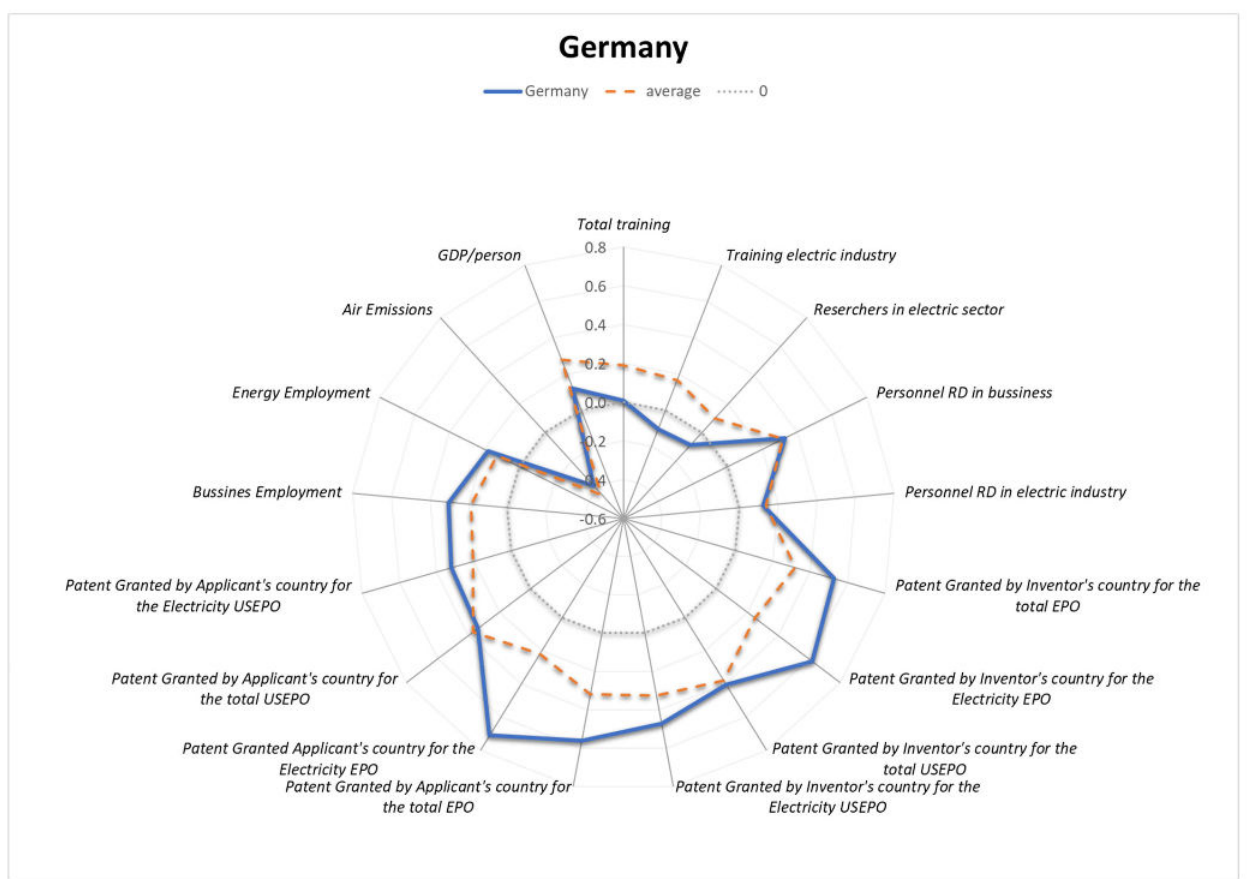
Figure 18. Synergy and trade-off occurrence—DE. Source: Authors’